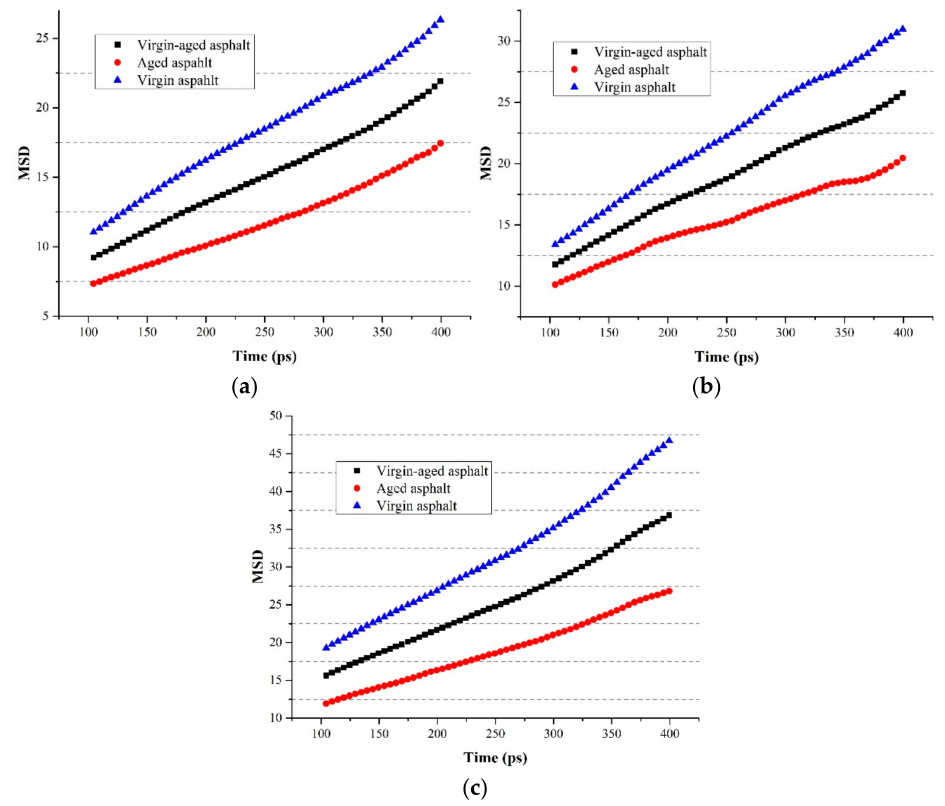
Figure 5. MSD at different temperatures: ( a ) 383.15 K; ( b ) 413.15 K; ( c ) 443.15 K.